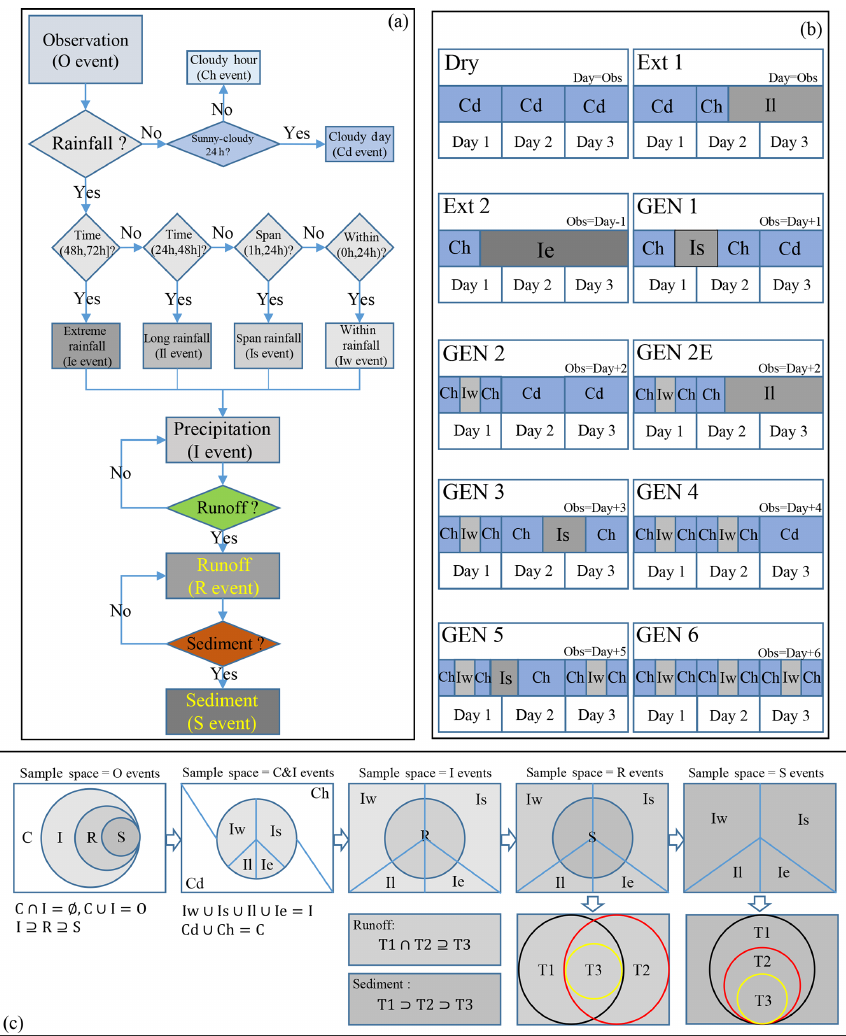
Figure 1. The OCIRS system: (a) a flow chart to determine random event types in the OCIRS framework; (b) the different combination patterns of rainfall and non-rainfall events in 3 consecutive days to form ten observed random event sequences in five rainy seasons; (c) Venn diagram showing the relationship between random event types in the OCIRS